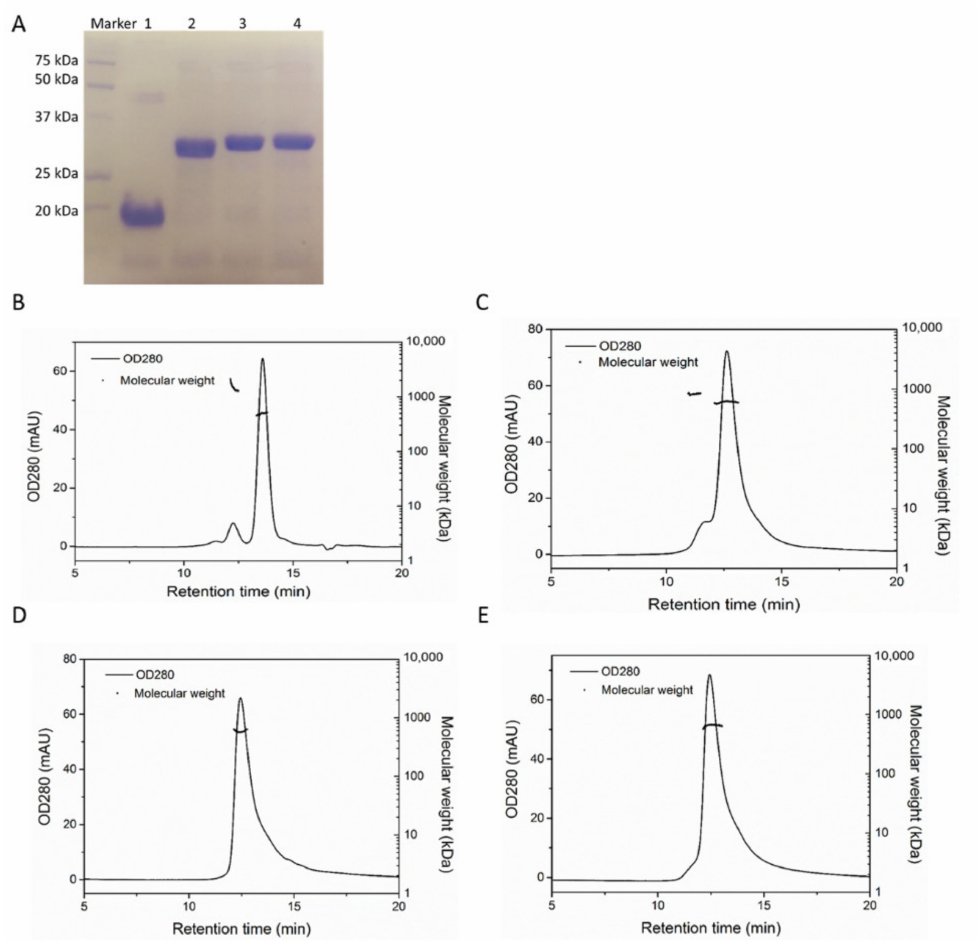
Figure 1. Characterizations of purified HFn-based proteins. ( A ), 12% reducing SDS-PAGE analysis of purified proteins. Lane 1, HFn; 2, HFn-PAS; 3, HFn-GFLG-PAS-RGDK; 4, HFn-PLGLAG-PAS- RGDK. ( B ), HPSEC-MALLS chromatogram of HFn. ( C ), HPSEC-MALLS chromatogram of HFn-PAS. ( D ), HPSEC-MALLS chromatogram of HFn-GFLG-PAS-RGDK. ( E ), HPSEC-MALLS chromatogram of